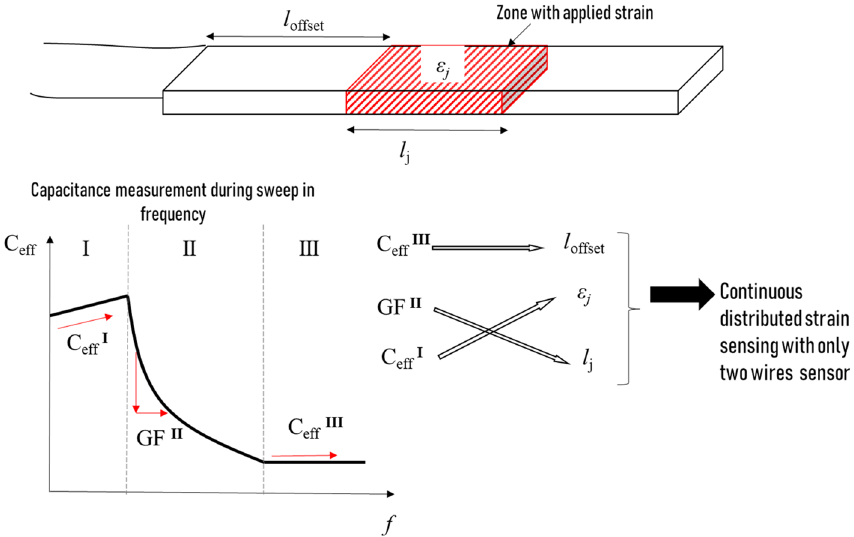
Figure 7. Measurement sequence and the information extractable by plotting capacitance measurements as a function of frequency. C III eff provides information about the length between the signal injection point and the beginning of the stretching zone ( l offset ), The combination of C I eff and GF II provides information about the local strain ε j and the length of the stretched domain l j .